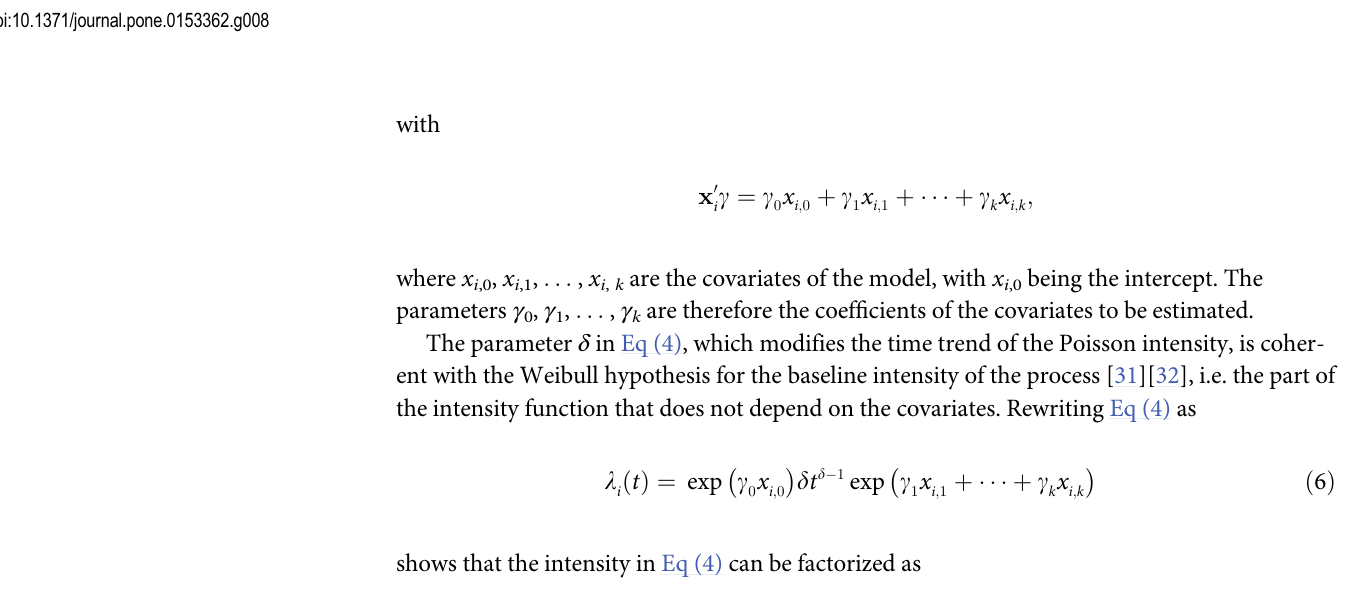
Fig 8. Maximum to Sum Plot. Maximum to Sum plot for the non-zero claims, first four moments ( p = 1, ... , 4). The convergence towards zero, in all four subplots, suggests that the corresponding moments are